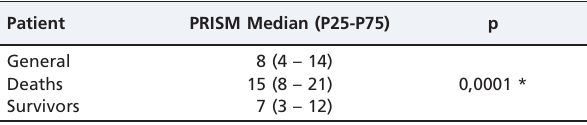
Figure 1 – Relationship between PRISM and the number of